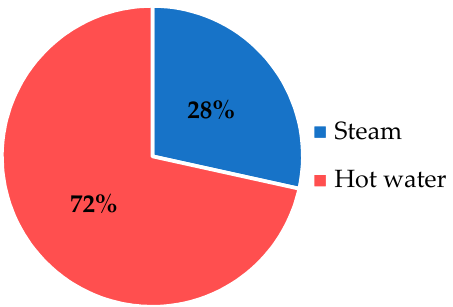
Figure 7. Structure of heat demand.